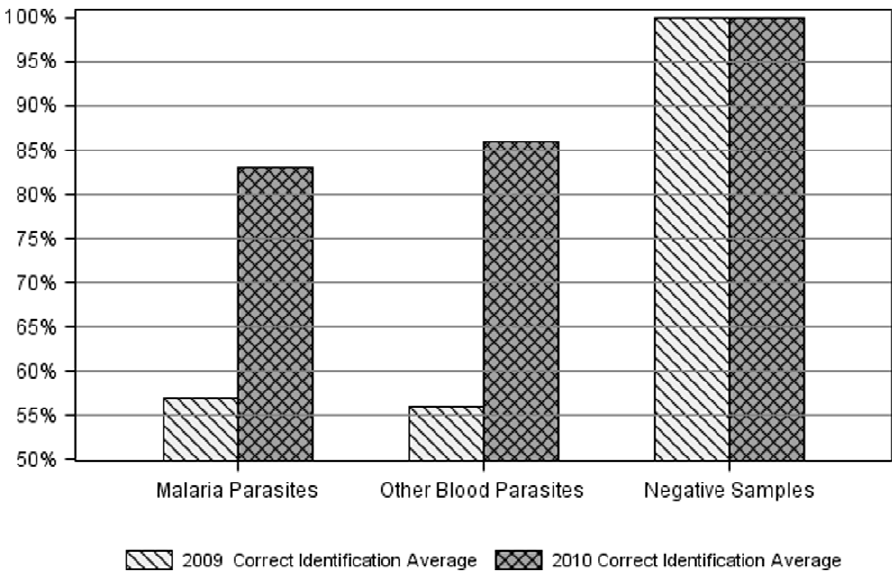
Figure 4. Average correct identification of the blood parasites surveys for all sites.